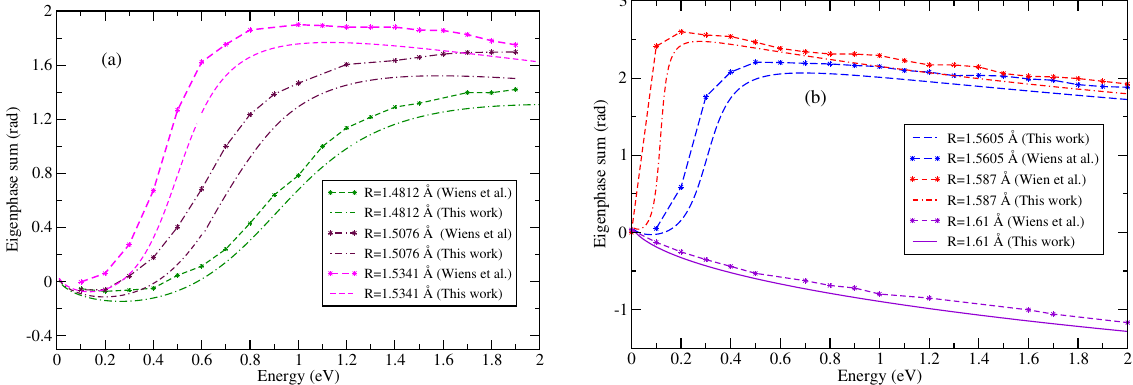
Figure 1. Eigenphase sum for the scattering symmetry 2 A 1 as a function of bond length in 12- states CC model ( a ) 1.4812 Å: dotted dashed curve; this work, dotted dashed curve with star, Wiens et al. [26], 1.5076 Å: dashed dotted curve; this work, dashed dotted curve with star; Wiens et al., 1.5341 Å: dashed curve; this work, dashed curve with star, Wiens et al. ( b ) 1.5605 Å: dashed curve; this work, dashed curve with star, Wiens et al., 1.587 Å: dashed dotted curve; this work, dashed dotted curve with star; Wiens et al., 1.61 Å: line curve; this work, line curve with star, Wiens et al. The symmetries like 2 B 1 , 2 B 2 and 2 A 2 do not exhibit any shape resonances and hence are not